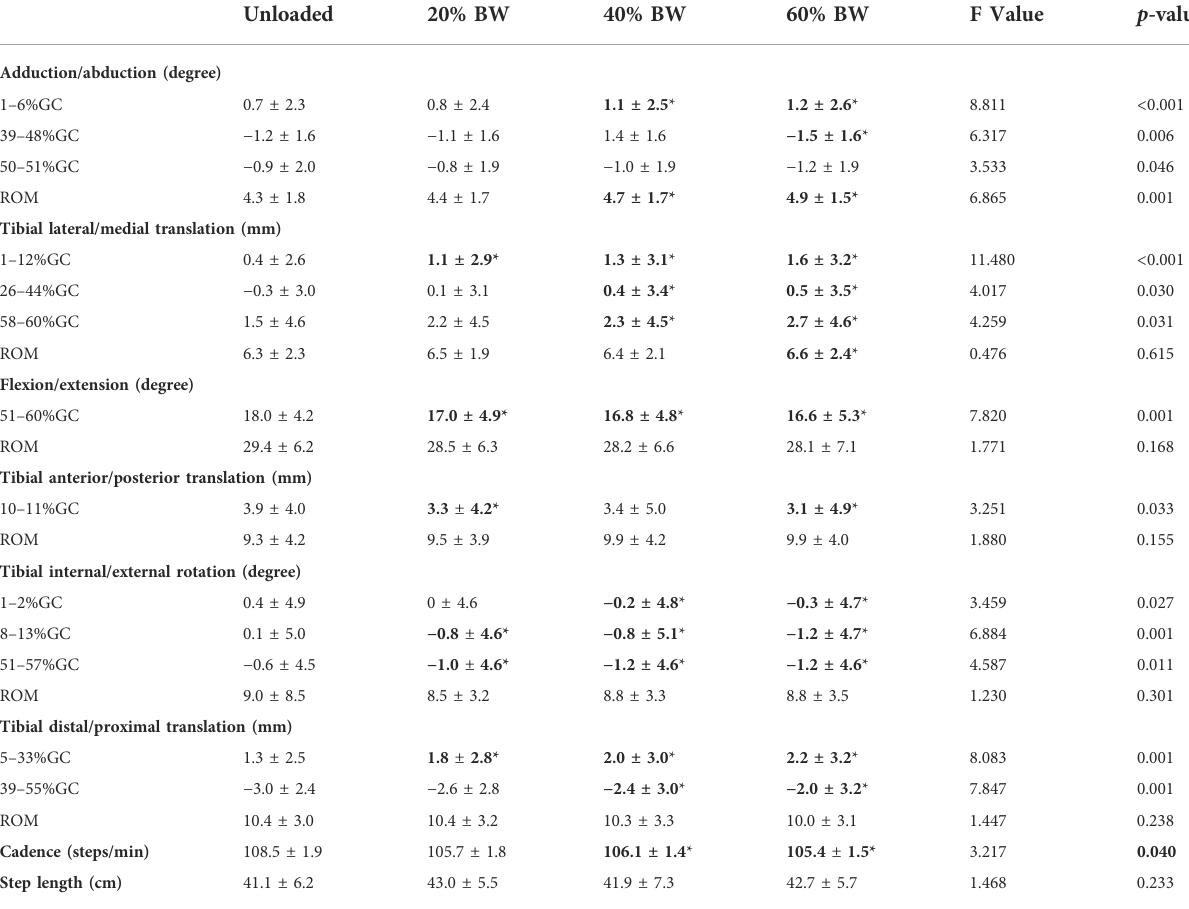
TABLE 1 Temporospatial parameters and kinematic comparison of the affected gait phases during load